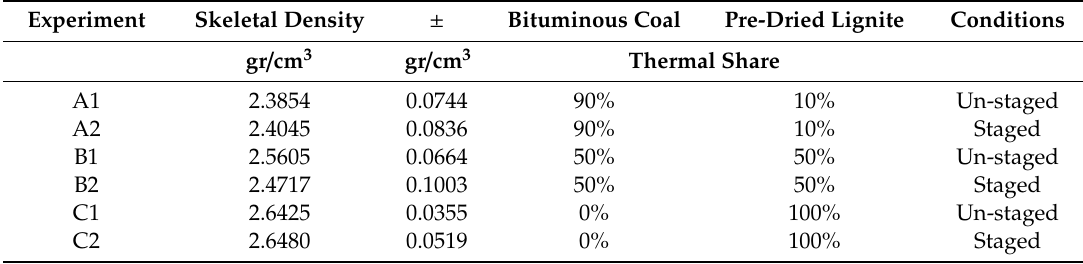
Table 4. Skeletal density of cyclone fly ash for each